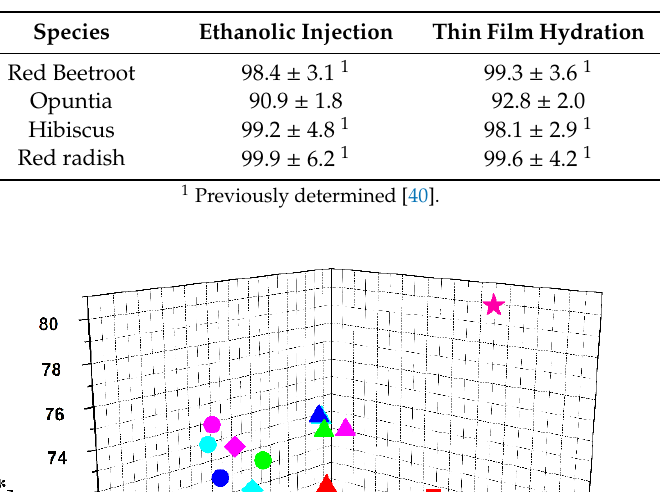
Table 3. Encapsulation efficiencies, EE (%) ± SD (%), of the several plant extracts in soybean lecithin liposomes, prepared by either by ethanolic injection or thin film hydration (SD: standard deviation).